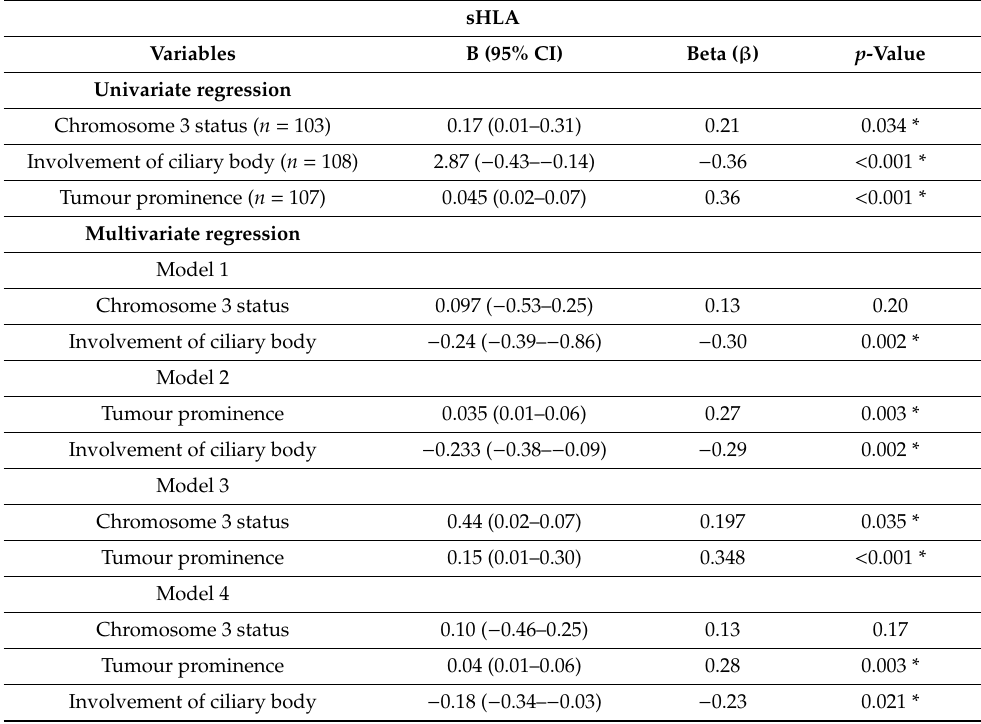
Table 3. Univariate and multivariate linear regression analysis on important prognostic tumour characteristics and sHLA expression in the aqueous humour of UM eyes (n = 108). B stands for the unstandardised regression coe ffi cient and Beta ( β ) is the standardised regression coe ffi cient. The β indicates the e ff ect that a change to the standard deviation (SD) of the independent variable has on the dependent variable. sHLA Variables B (95% CI) Beta ( β ) p